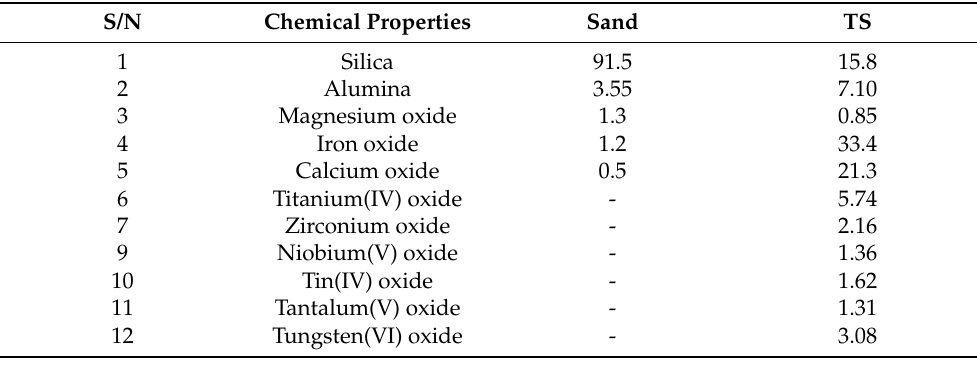
Figure 1. The macro morphology of tin slag.